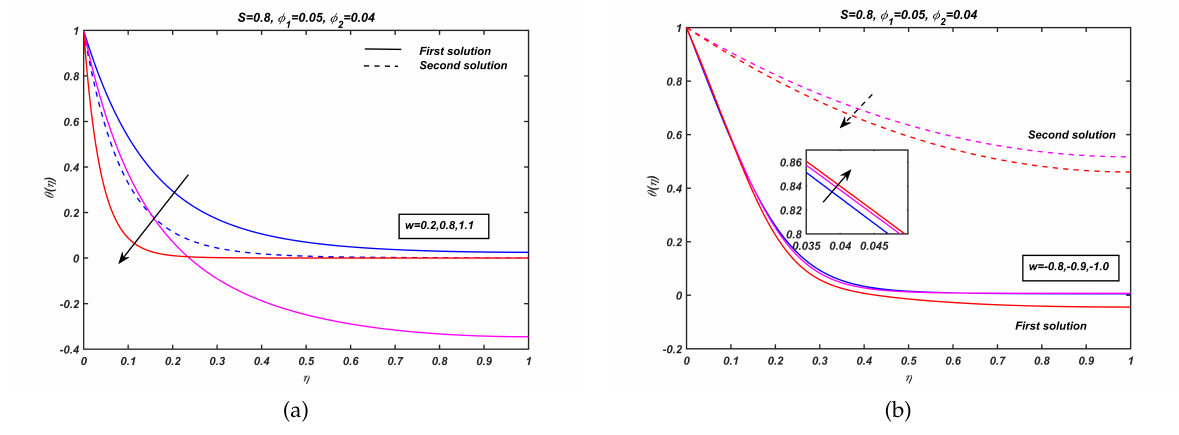
Fig. 5. Effect of w on temperature for suction case (a) and injection case